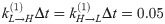
Validation of VB-DCMM on synthetic data.(A) (i) A time trace of internal state generated with γ(1)→(2)Δt = γ(2)→(1)Δt = 0.001. (ii) An observable time trace generated based on the trace of internal state in (i) by using internal state-dependent parameters kL→H(1)Δt=kH→L(1)Δt=0.05, kL→H(2)Δt=0.00625, kL→H(2)Δt=0.025. (iii) An synthetic FRET data with Gaussian noise overlaid on the trace in (ii). (iv) Noised filtered FRET state by HMM (blue line). (v) Traces of internal state with different K, estimated using VB-DCMM on the noise-filtered FRET trace from (iv) (black line is the true internal state trace while red, orange, and blue are internal state estimated from the model with K = 1, 2, and 3, respectively. The indices of internal state were determined by comparing B(μ) estimated for each internal state with B(μ),true which is used to generate the synthetic data). (B) Estimated lower bound of the evidence function F(K) of DCMM models with K = 1, 2, and 3. (C) Accuracy of detecting internal states. The overlap function χ calculated for 100 synthetic FRET traces generated under the identical condition used for generating the trace of internal state shown in (A).